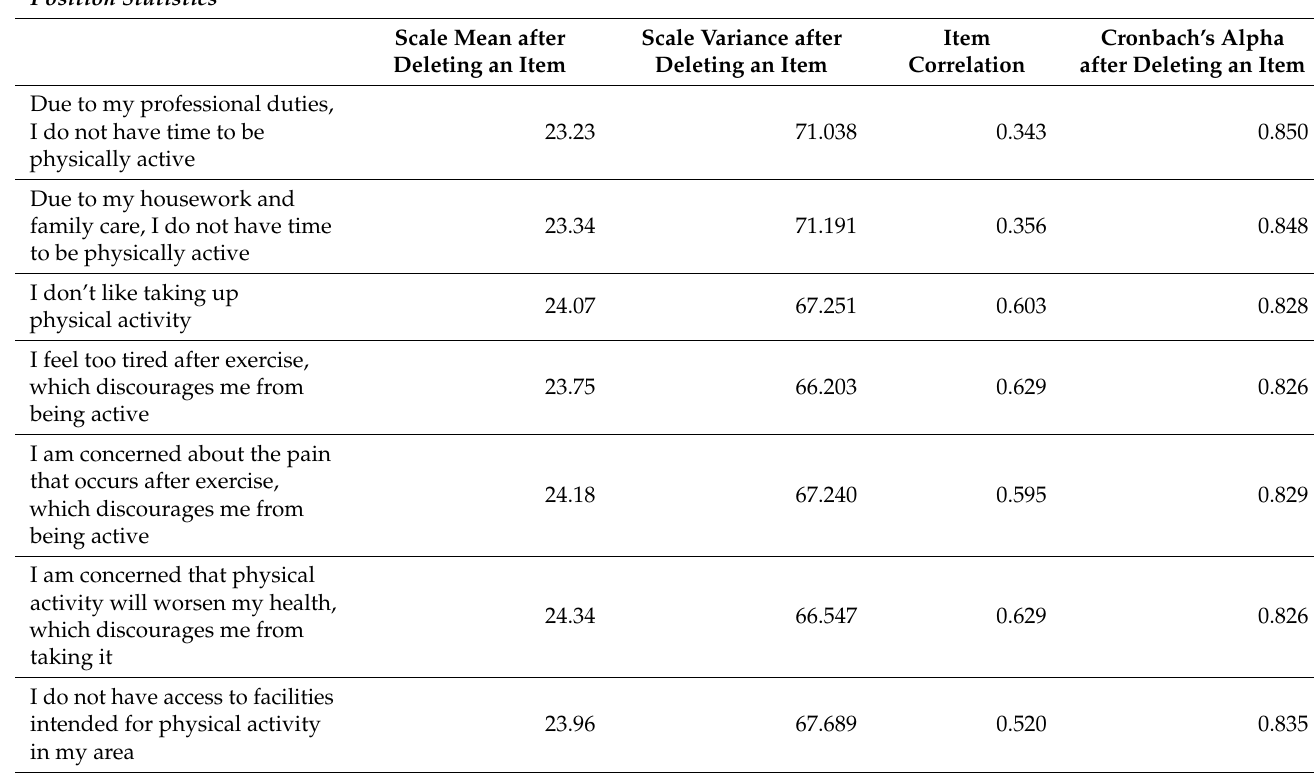
Table A2. The full list of statements accessing the barriers to participate in regular PA in the nurse population and their consistent validity